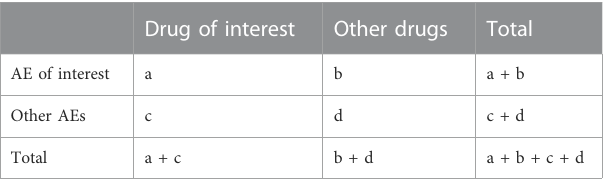
TABLE 2 Two-by-two contingency table for disproportionality analysis. Drug of interest